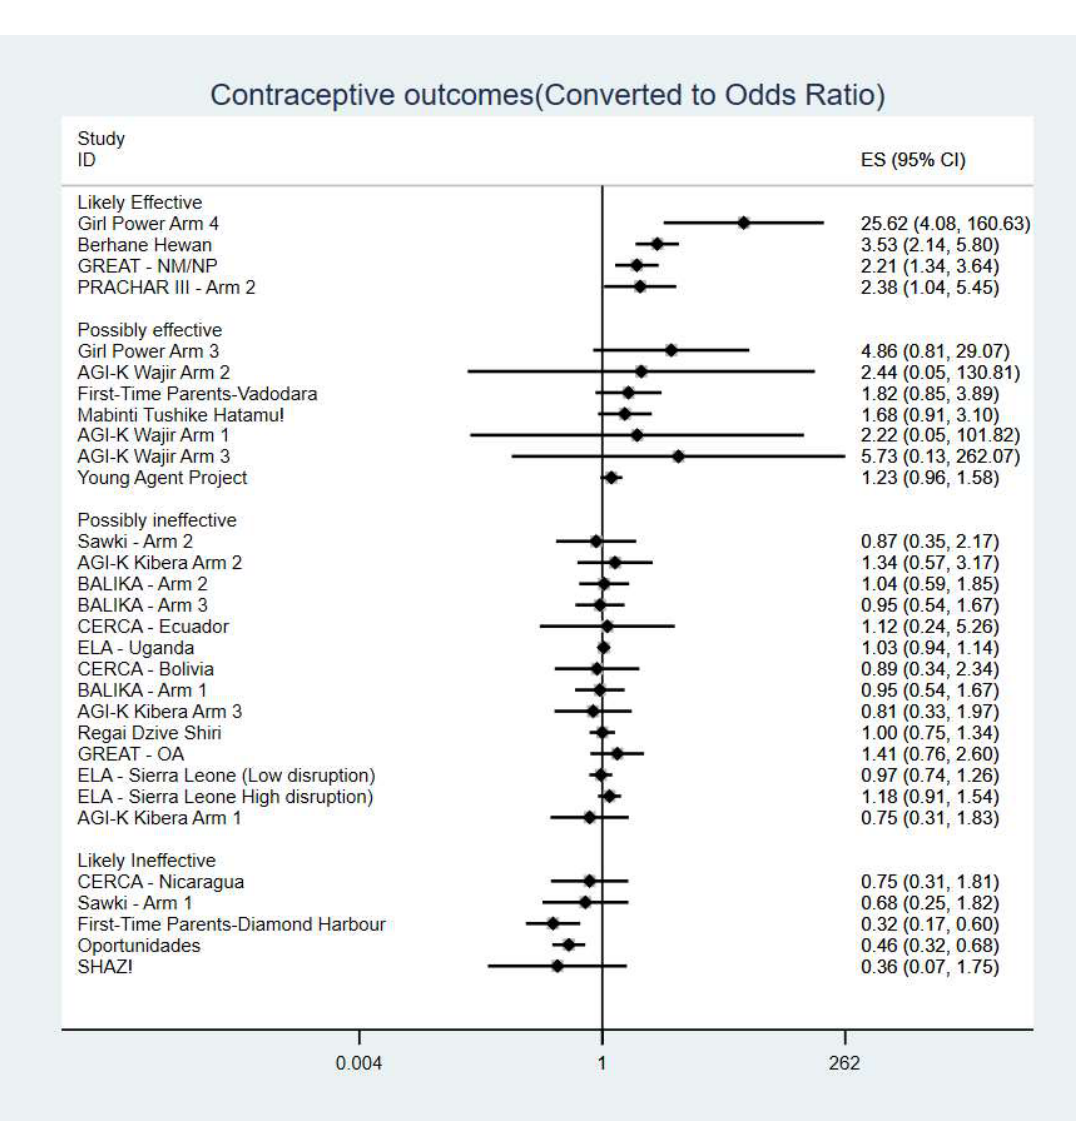
Figure 1. Study arms categorised by likelihood of effect.